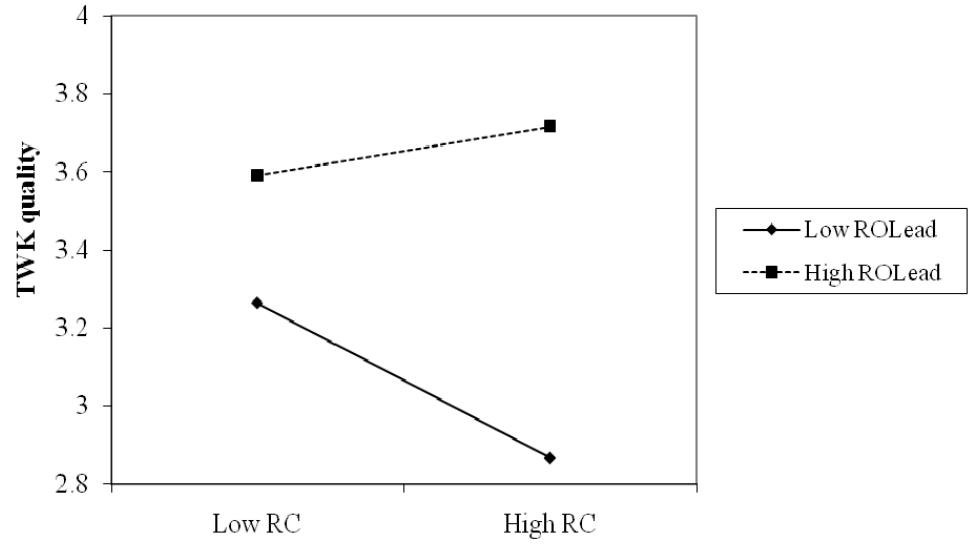
style (ROLead) on teamwork quality (TWK quality).